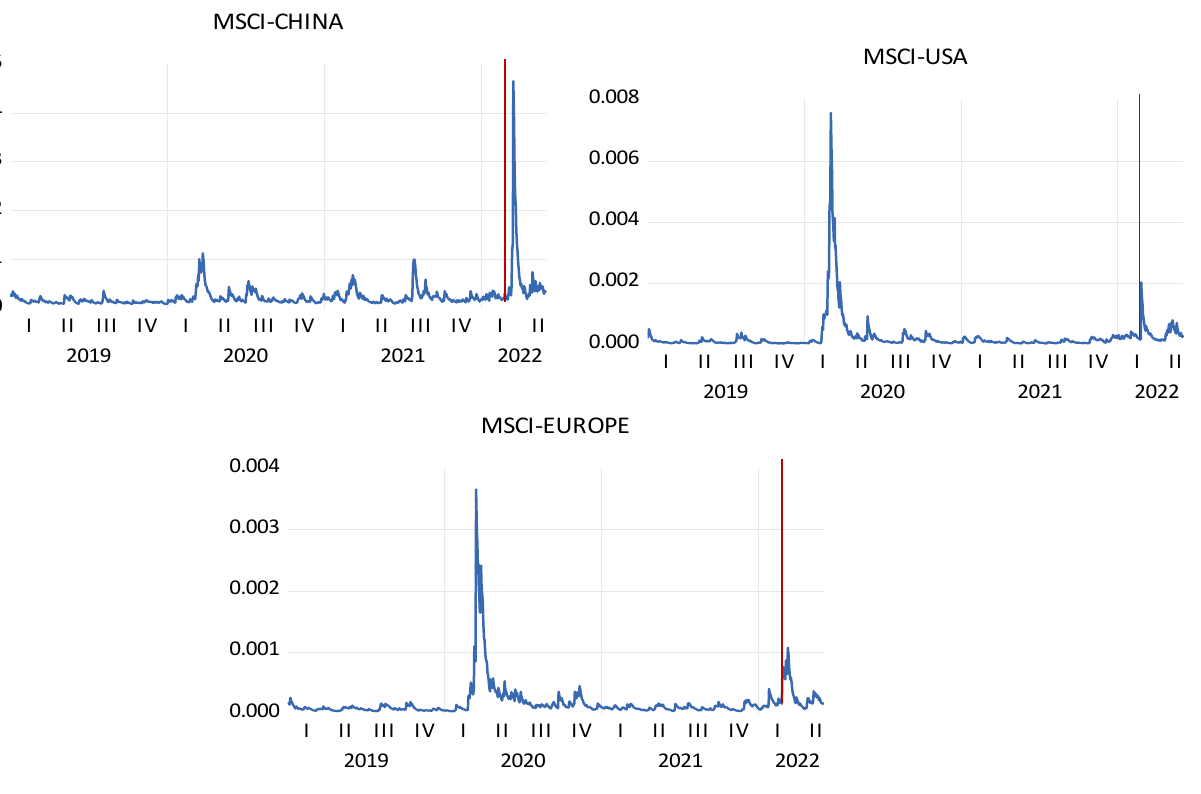
Figure 3. Daily index volatility.